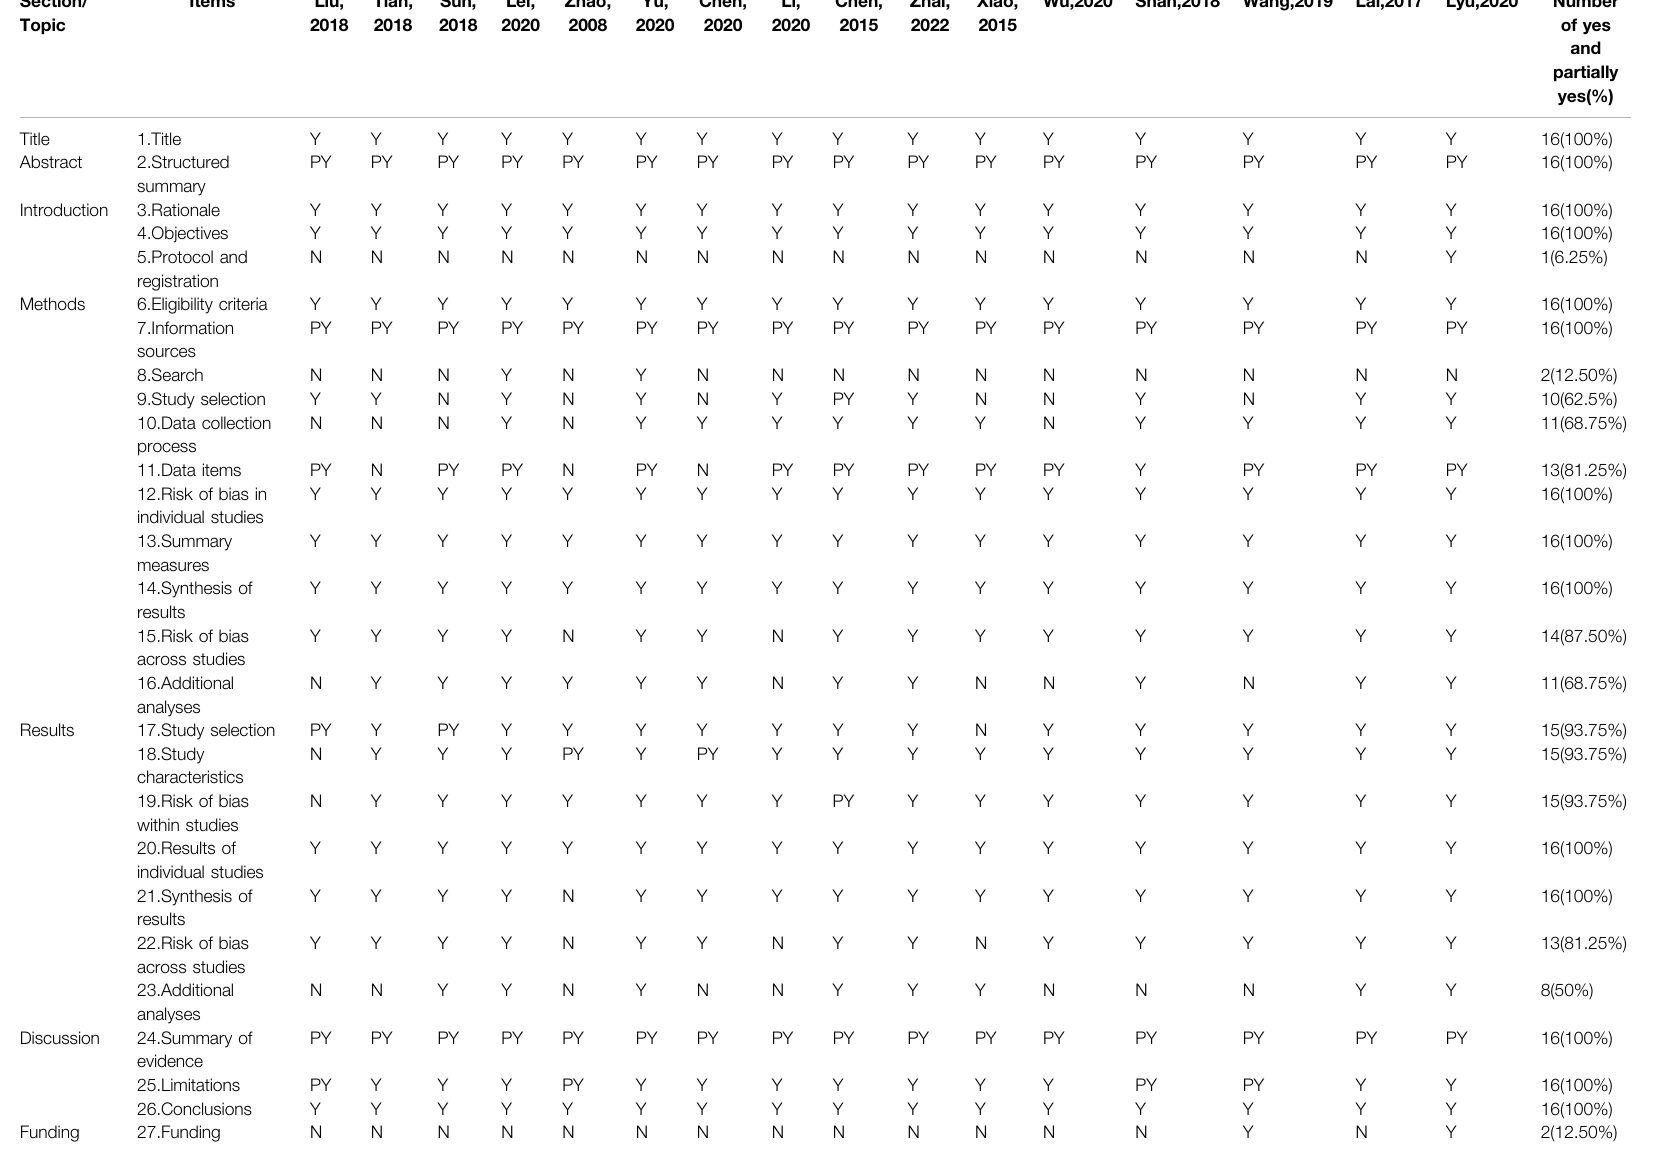
TABLE 6 | Results of the PRISMA